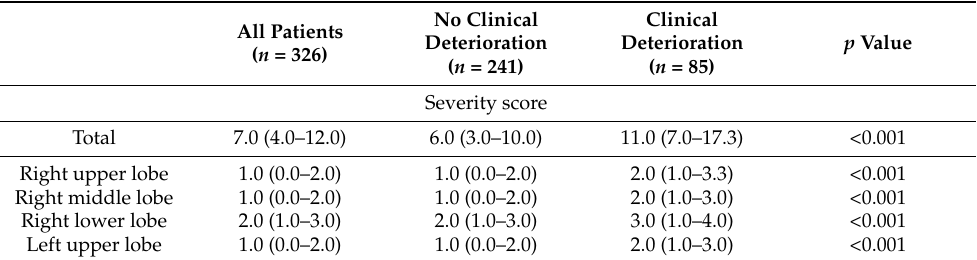
Table 4. Severity scores calculated by the deep learning model based on the quantitative measure- ments.